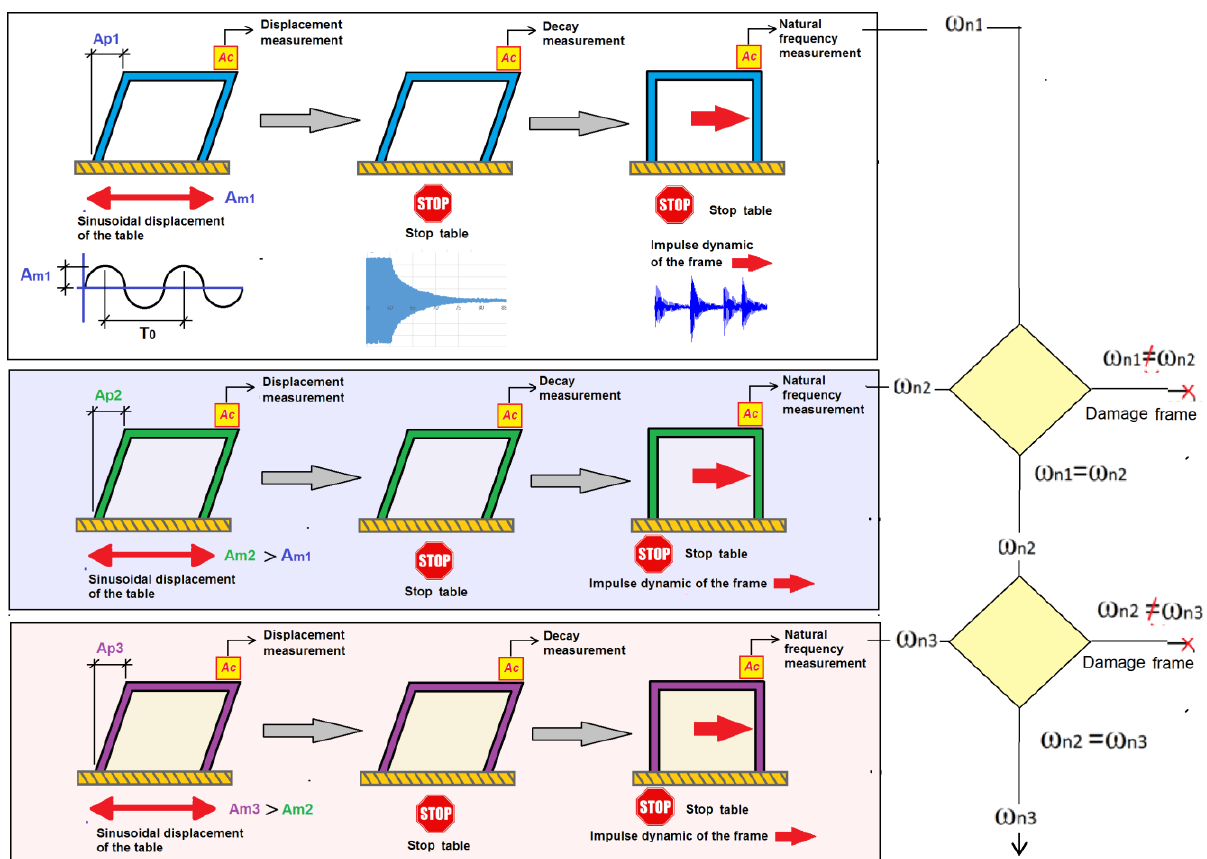
Figure 4. Diagram of the methodology used.